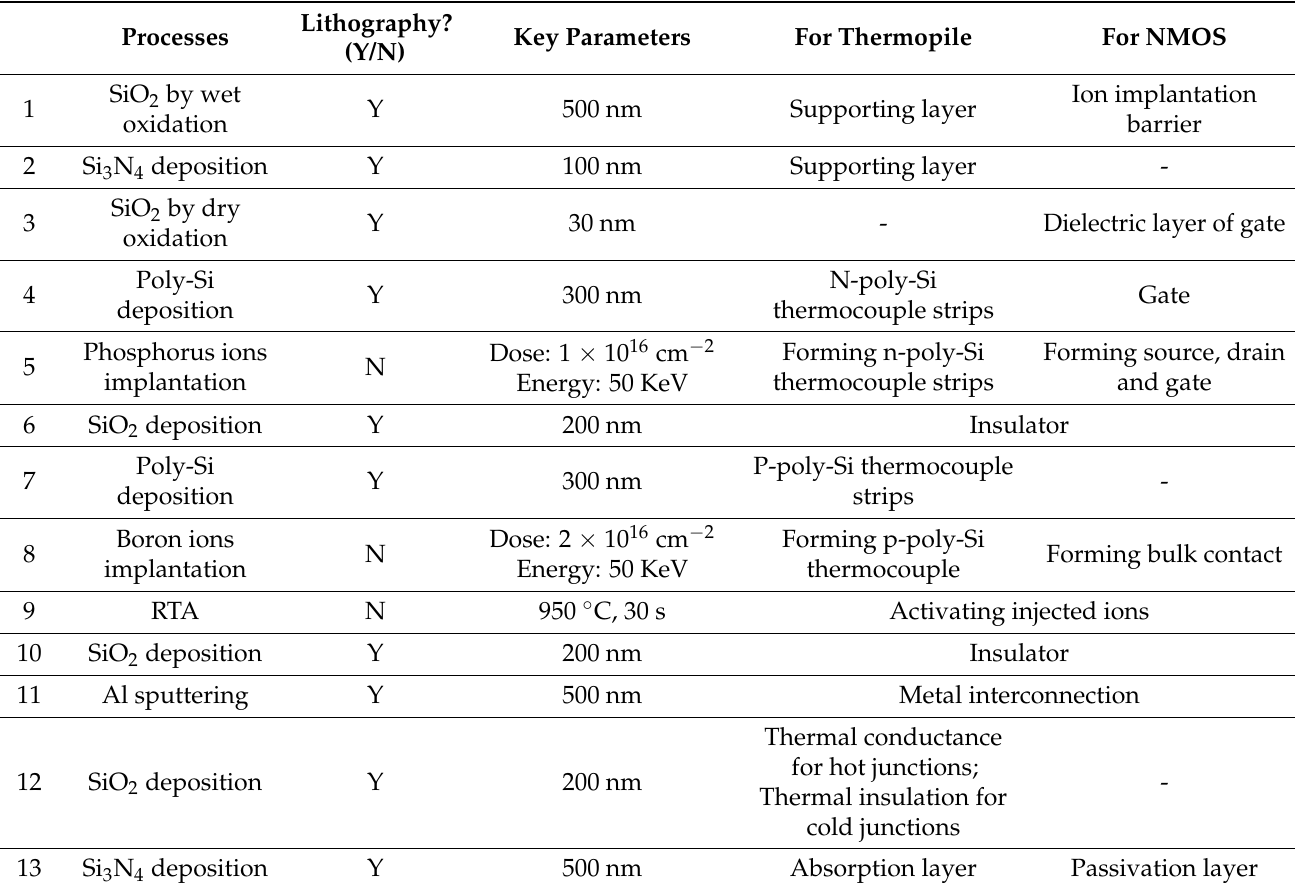
Table 1. Role of each process and each